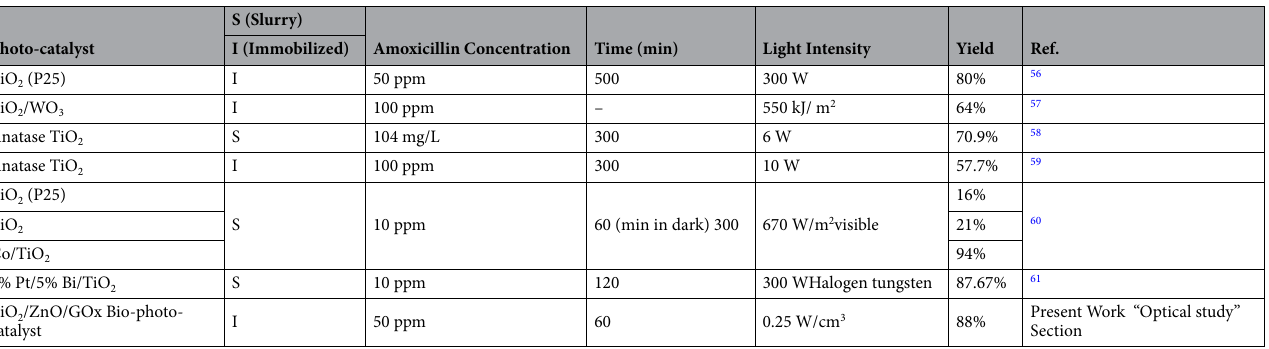
Table 3. Comparison of this work with the recent reports on amoxicillin degradation.